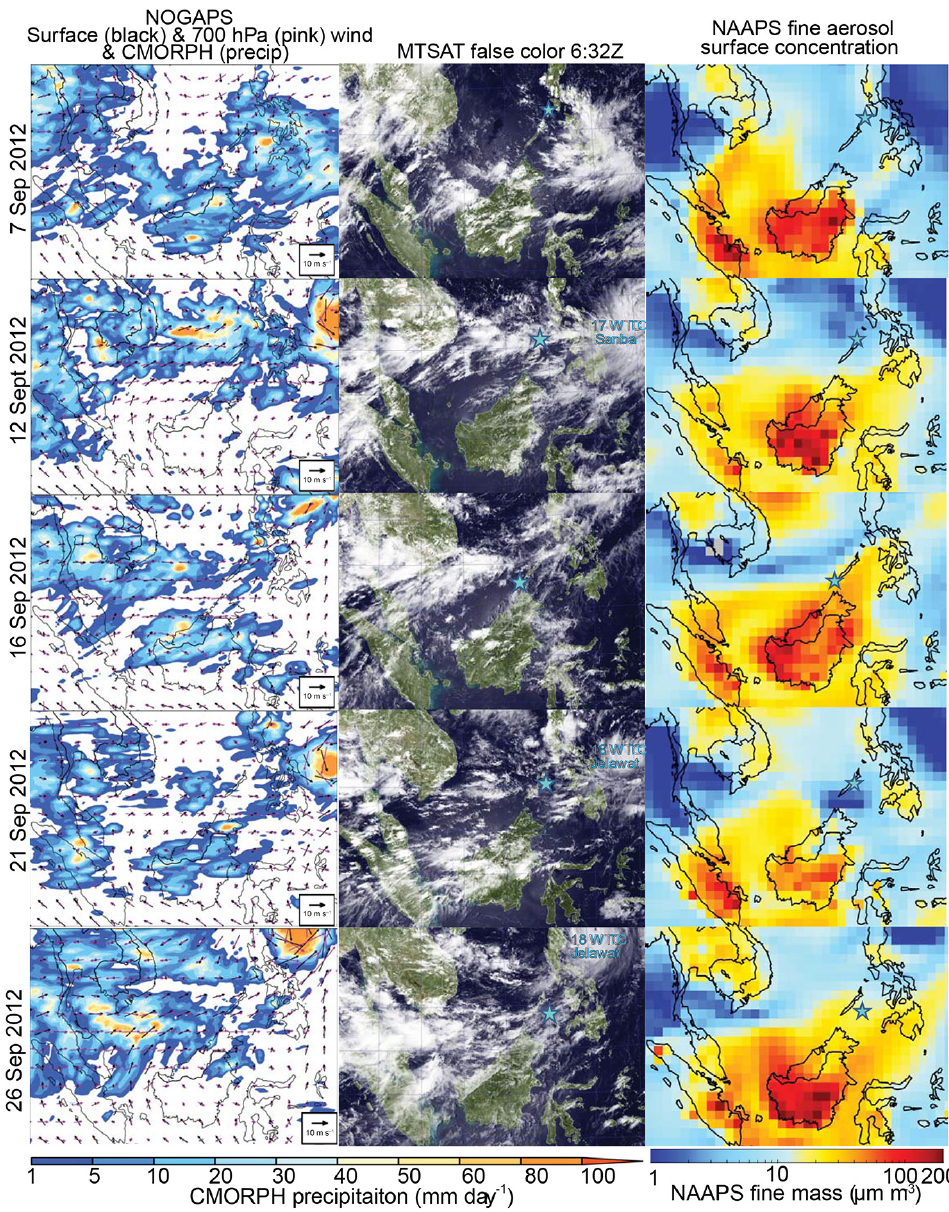
Figure 2. A matrix of NOGAPS wind (black indicates surface; pink is 700hPa) and CMORPH precipitation, MTSAT visible false color imagery, and NAAPS surface fine-mode particle concentration (biomass burning plus anthropogenic and biogenic fine) for 5 representative days at major anchorages throughout the Vasco cruise. Selected dates are at major sampling moorings/anchorages: 7 September at Apo